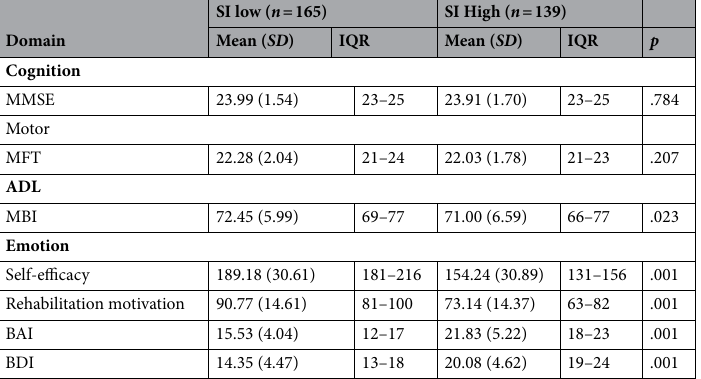
Table 2. Comparison of cognitive functions, motor functions, ADL, emotional functions between both groups. Abbreviations: SI, suicidal ideation; SD , standard deviation; IQR, interquartile range; MMSE, mini-mental state examination; MFT, manual function test; MBI, modified Bathel index; BAI, beck anxiety inventory; BDI, beck depression inventory.